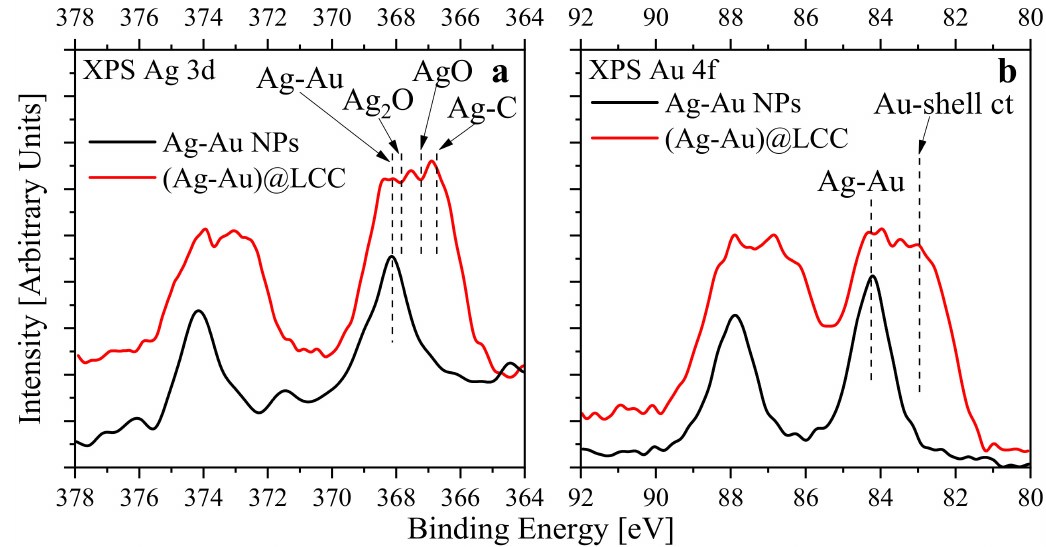
Figure 5. XPS spectra of Ag-Au and (Ag-Au)@LCC: ( a ) Ag 3d and ( b ) Au 4f. Label “Au-shell ct” designates charge transfer between Au atoms and LCCs